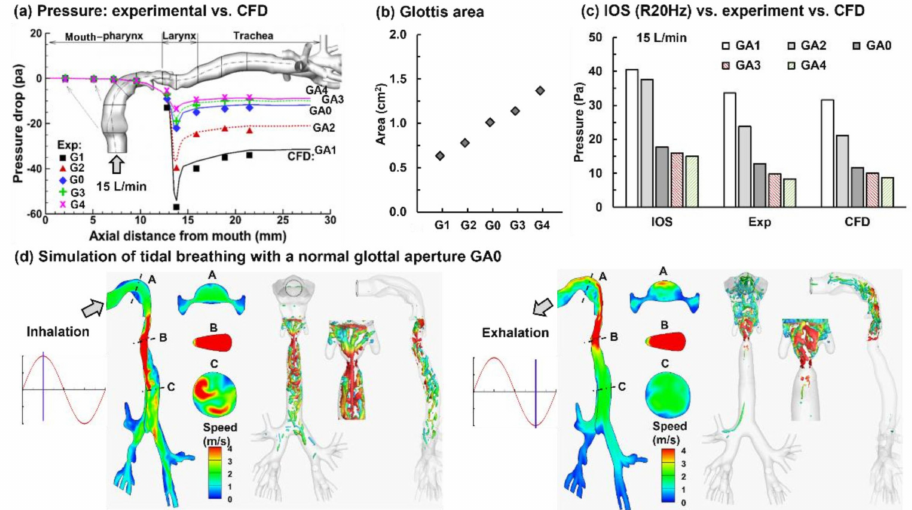
Figure 5. Cross-validation of the pressure drop (resistance) between the IOS, in vitro experiments, and numerical simulations: ( a ) experimentally measured pressure gradients within the 3D hollow cast vs. CFD (computational fluid dynamics) simulations at a flow rate of 15 L/min, ( b ) the glottis area of G0–4, and ( c ) the converted resistances (i.e., R5Hz and Pa) at 15 L/min in comparison to the experiments and CFD predictions for the five models G0–4. Computational simulations of tidal breathing with a static normal glottal aperture are shown in ( d ) at the peak inhalation (left panel) and exhalation (right